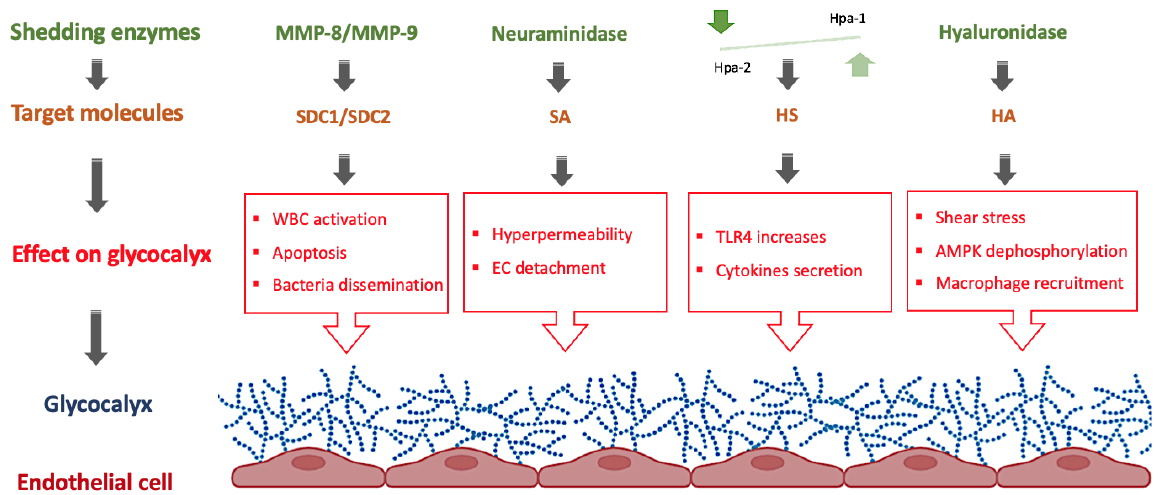
Figure 2. Role of shedding enzymes on the eGC in neonatal sepsis. AMPK: AMP-activated protein kinase, EC: Endothelial cells, HA: hyaluronan, Hpa: heparanase, HS: heparan sulfate, MMP: matrix metalloproteinases, SA: Sialic acid, SDC: syndecan, TLR: toll-like receptors, WBC: White blood cells. Figure created with BioRender.com.